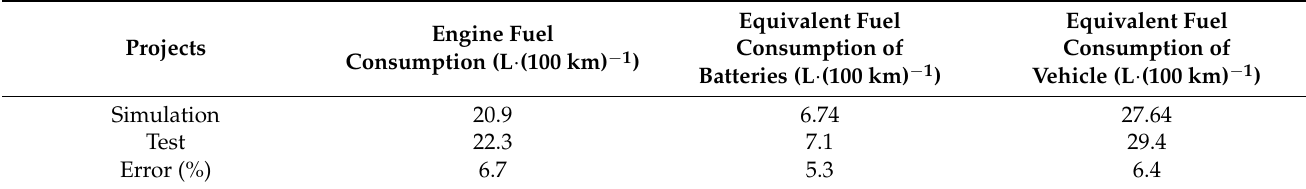
Table 10. Comparison between the simulation and test of fuel economy.